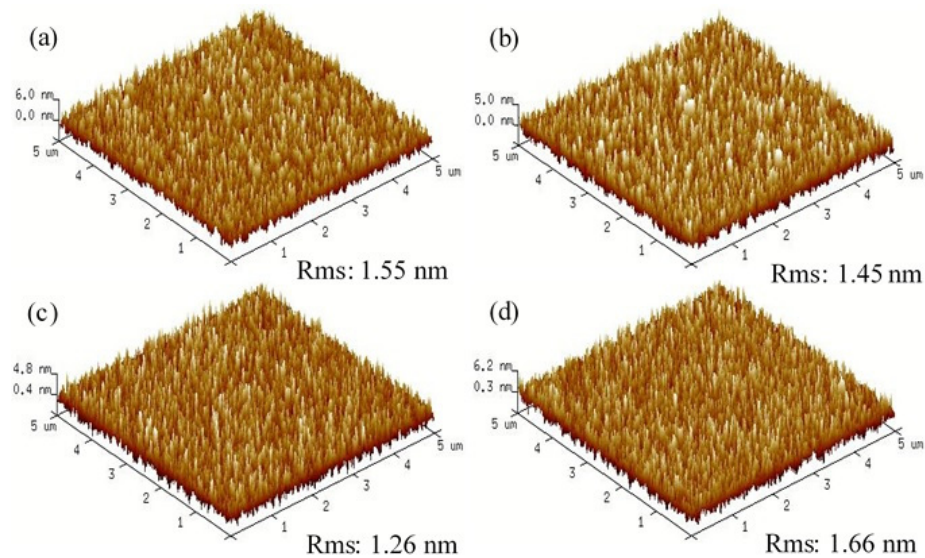
Figure 2. 3D AFM of SbGaN films at different sputtering temperatures of ( a ) 100 °C, ( b ) 200 °C, ( c ) 300 °C, and ( d ) 400 °C.